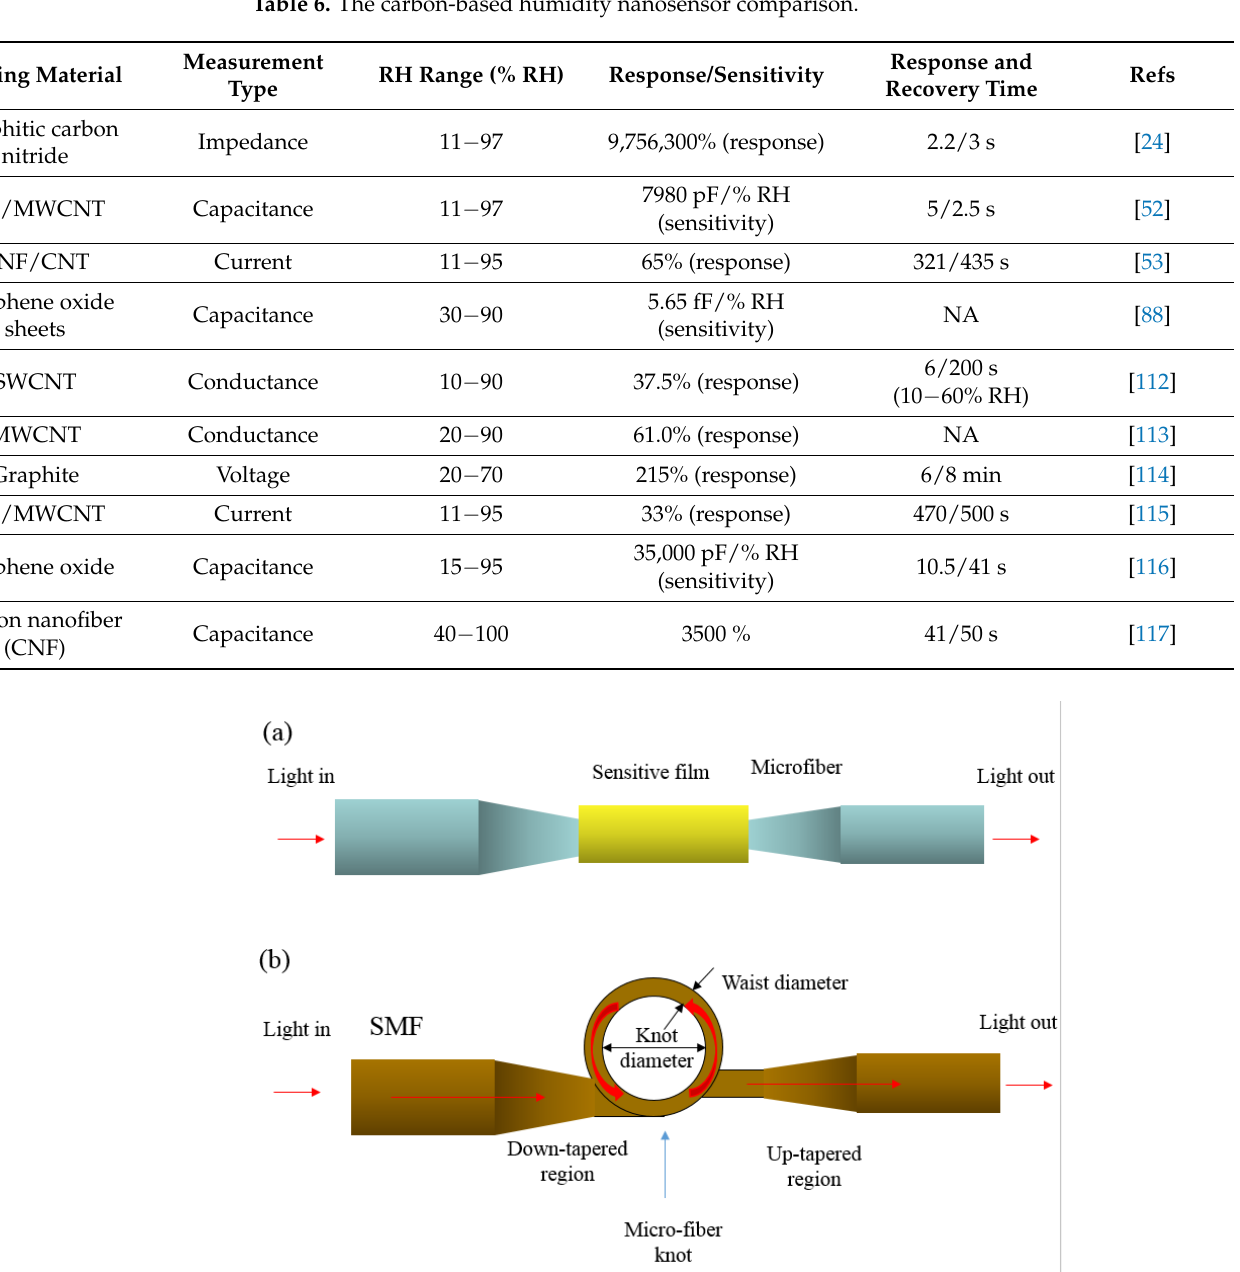
Table 6. The carbon-based humidity nanosensor comparison.